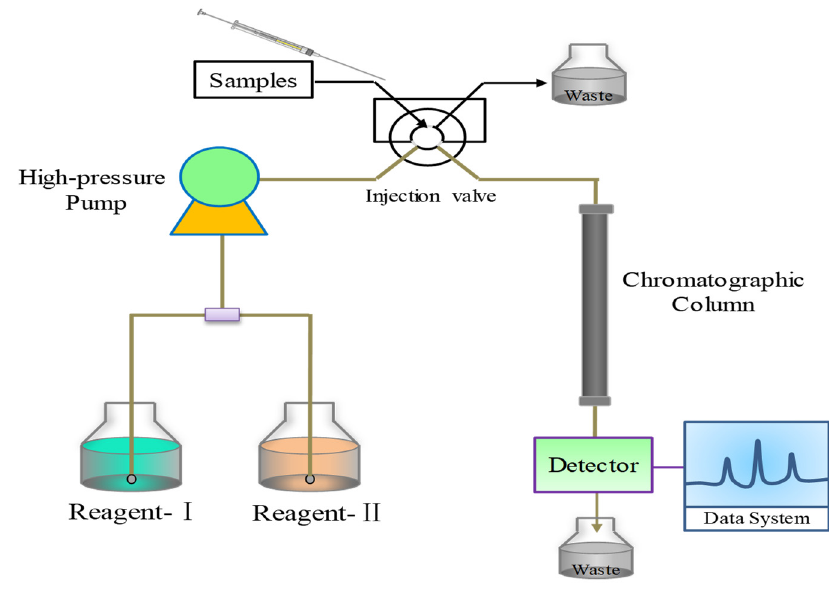
Figure 4. Schematic diagram of HPLC analysis system. Table 7. Various HPLC methods for the detection of ACV (“N.A”: No data applicable or available).